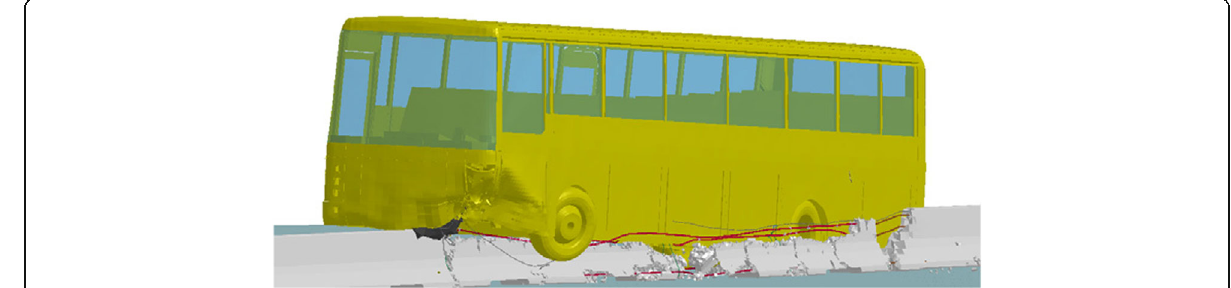
Fig. 5 Concrete barrier, bus 13 t, 80 km/h,